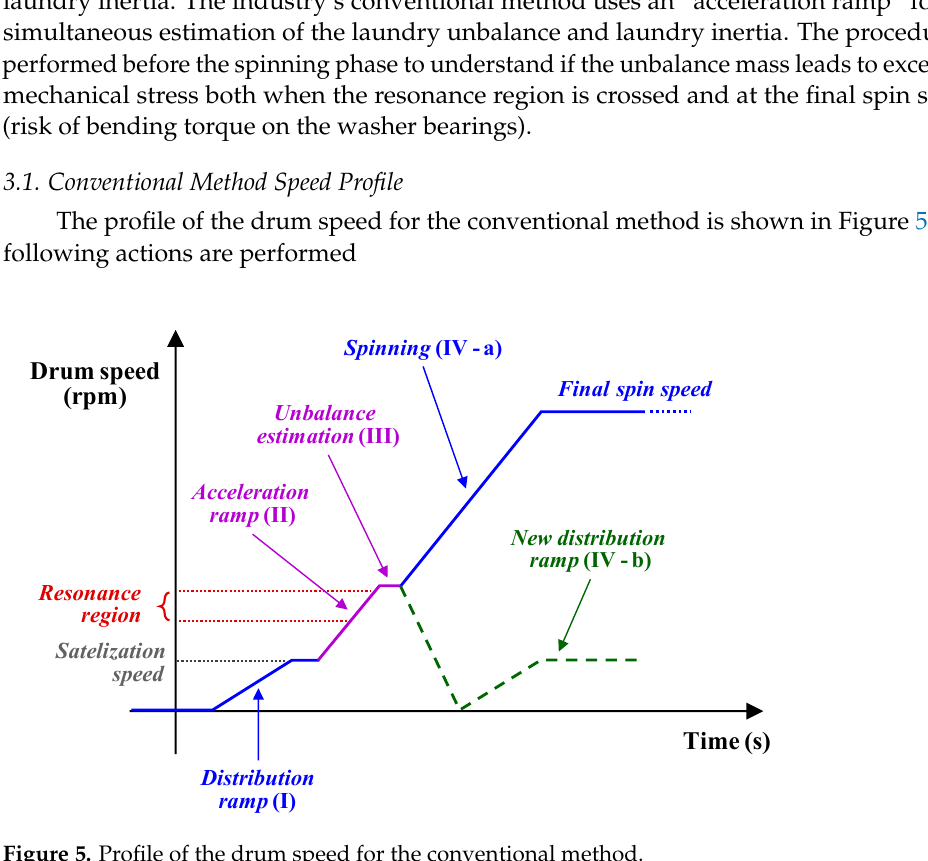
Figure 5. Profile of the drum speed for the conventional method.